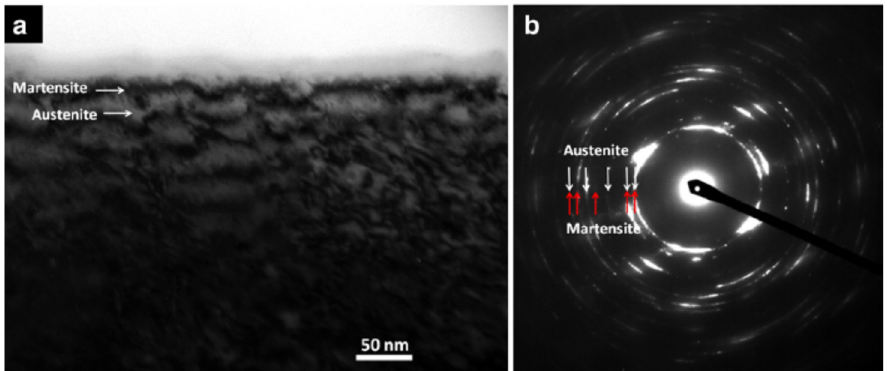
Figure 9. TEM of UNSM-treated AISI 304 steel: ( a ) at the top surface, ( b ) SAED pattern. Reprinted with permission from ref. [44]. Copyright 2013, Elsevier.